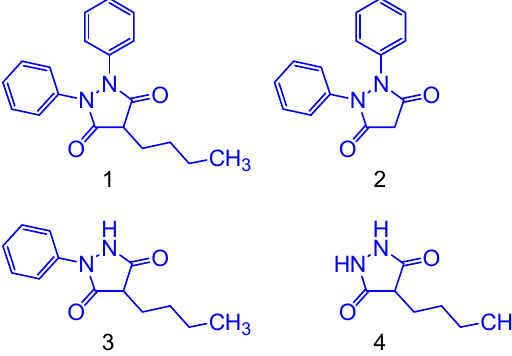
Figure 2. Molecular simplification of phenylbutazone.